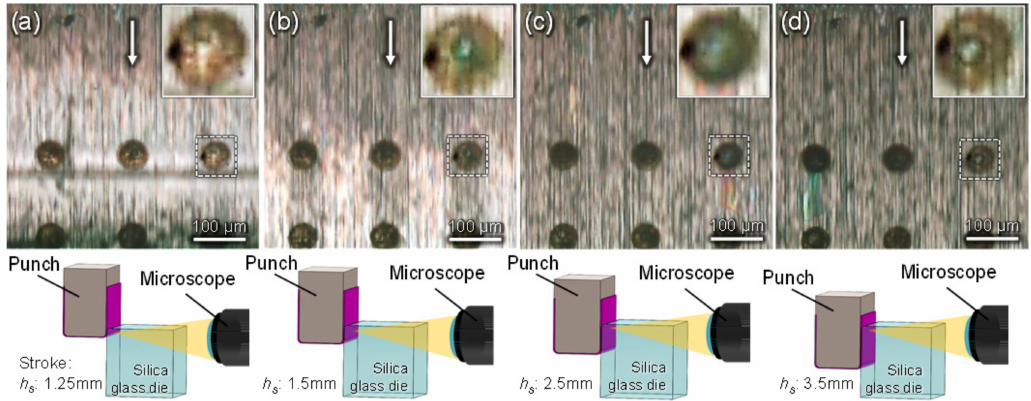
Figure 6. Captured images from in-situ observations at various punch strokes of ( a ) h s :1.25 mm, ( b ) h s :1.5 mm, ( c ) h s :2.5 mm and ( d ) h s :3.5 mm in bending with the ironing process using the surface textured die with a dimple diameter of 50 µ